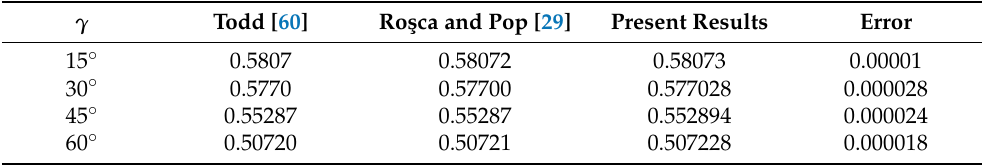
Table 3. Comparison of present results with literature